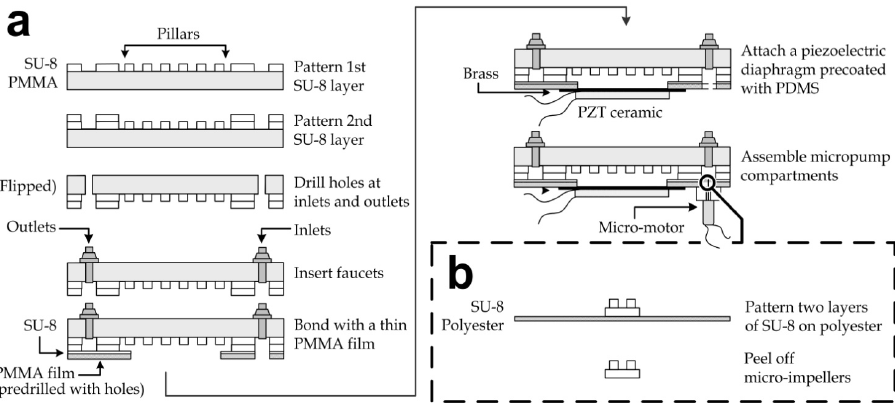
Figure 1. Fabrication processes of ( a ) the microfluidic mixing module array and ( b ) the micro